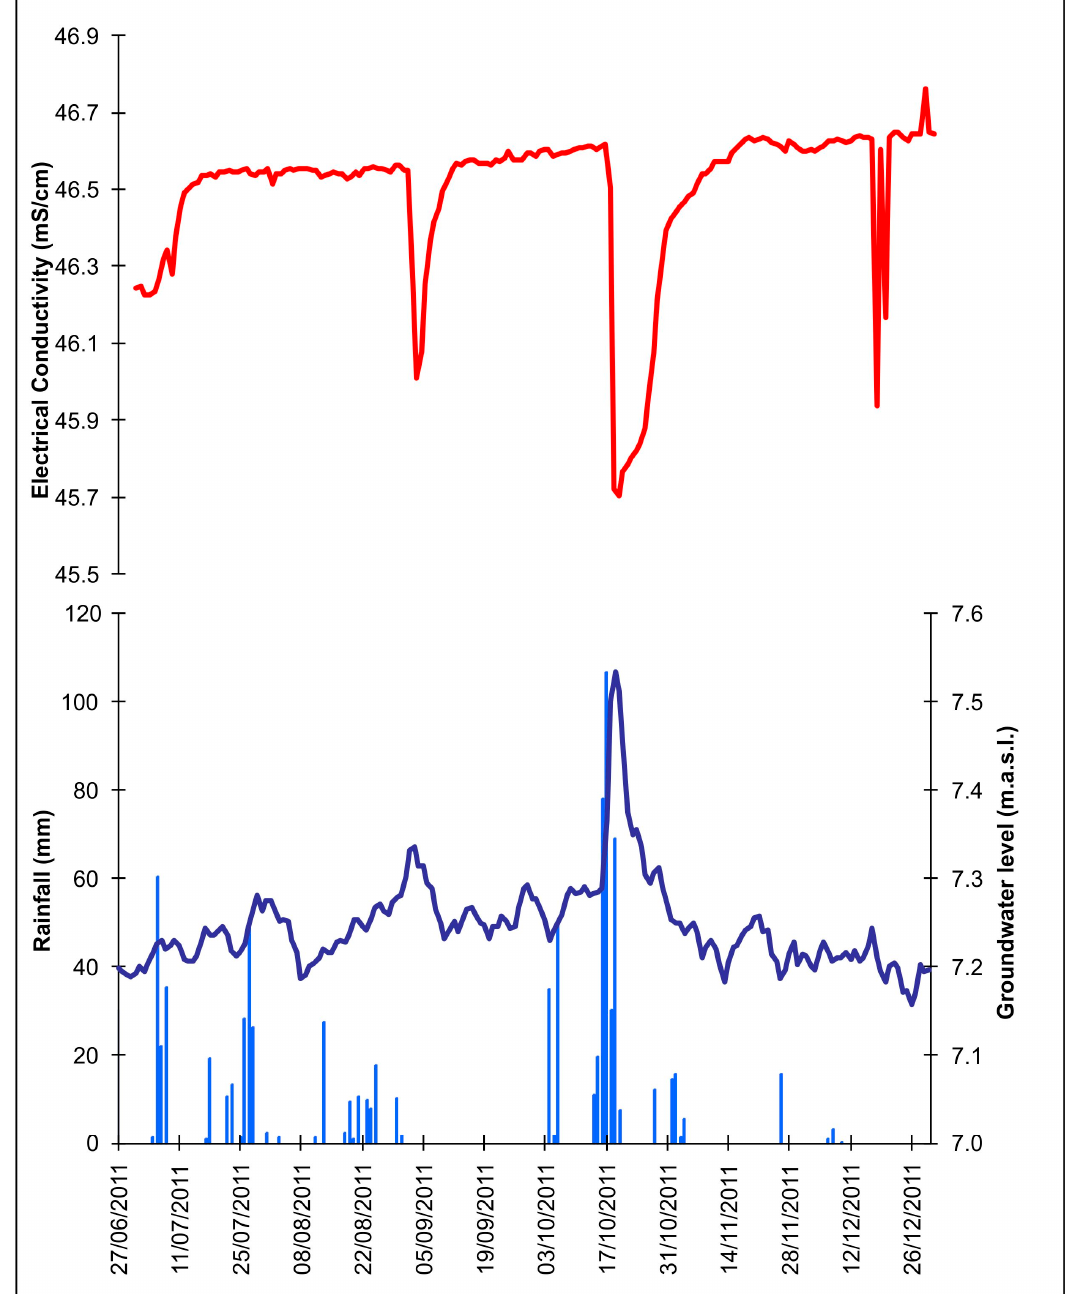
Figure 5. Temporal variation of rainfall, groundwater level and electrical conductivity in well 18.